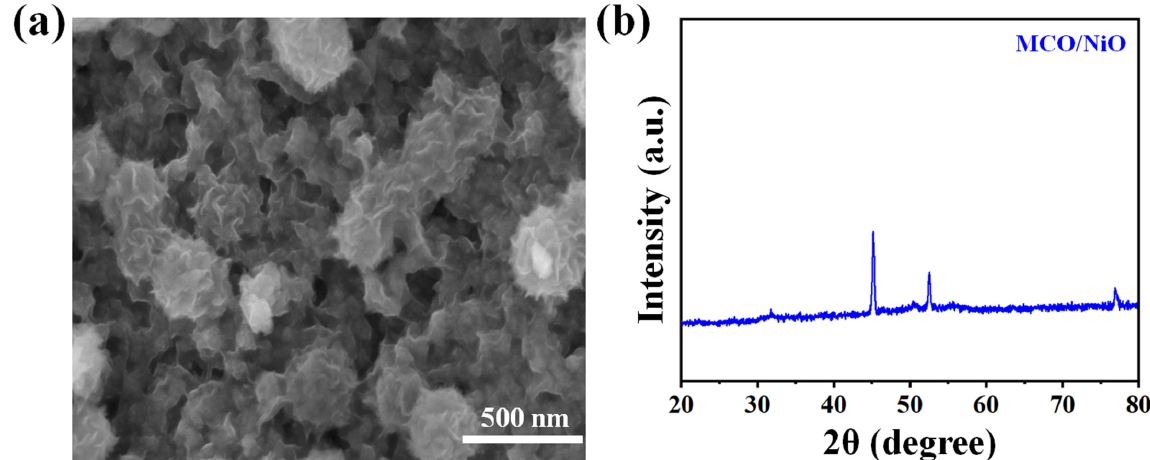
Figure 6. After cycling stability test, ( a ) SEM, and ( b ) XRD of the MCO/NiO composite electrode material.